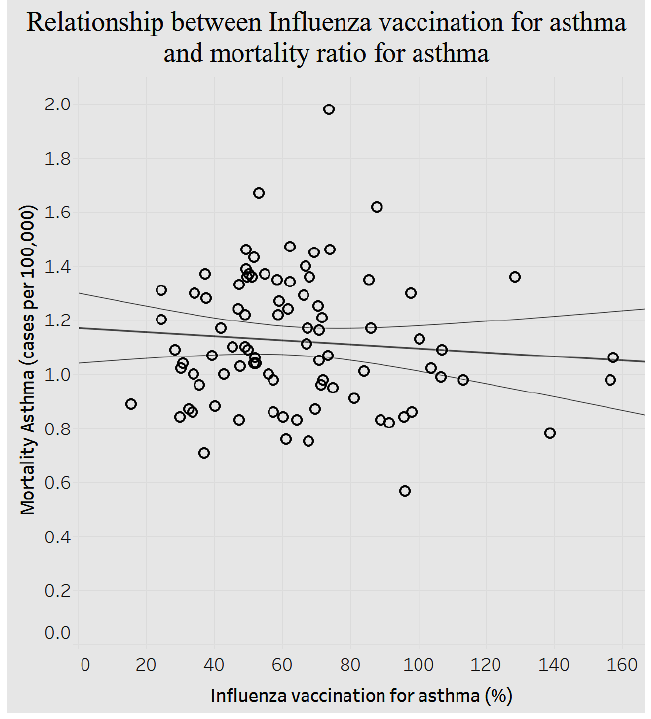
Figure 15. Mortality ratio for asthma and influenza vaccination for asthma.